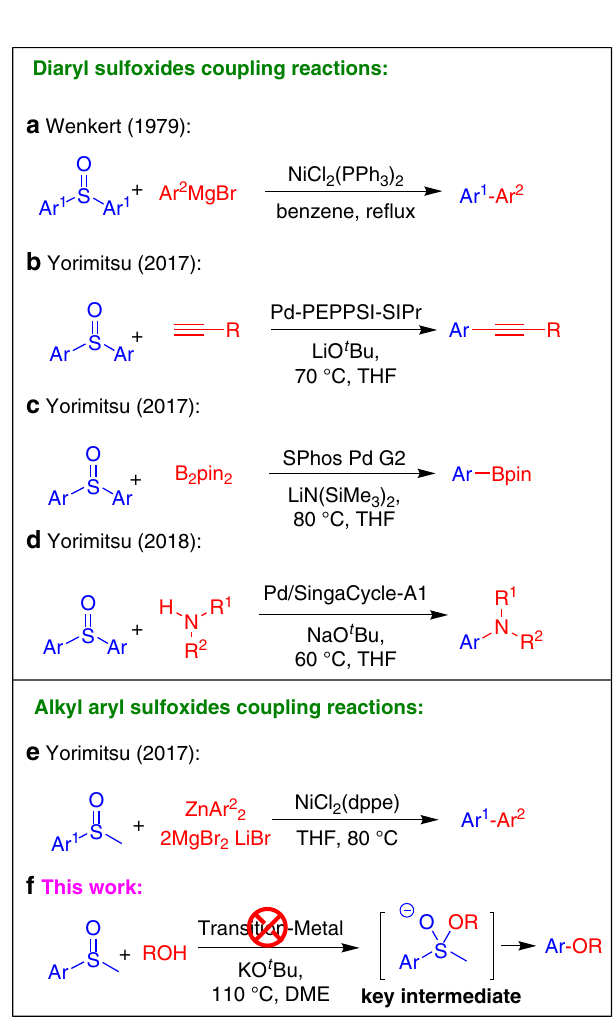
Fig. 1 Cross-coupling reactions employing sulfoxides as electrophiles. a Nickel-catalyzed Kumada coupling reaction of diaryl sulfoxides. b Palladium-catalyzed Sonogashira coupling reaction of diaryl sulfoxides. c Palladium-catalyzed borylation of diaryl sulfoxides. d Buchwald-Hartwig amination of diaryl sulfoxides and amines. e Nickel-catalyzed Negishi coupling reaction of aryl methyl sulfoxides. f This work: transition-metal- free formal cross-coupling of aryl methyl sulfoxides and